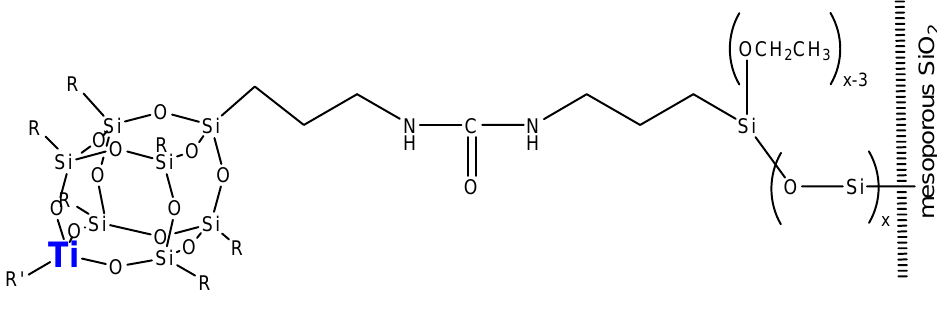
Figure 11. Anchoring of a Ti-containing polysilsesquioxane moiety onto the surface of SBA-15 silica (R = isobutyl; R’ = isopropyl